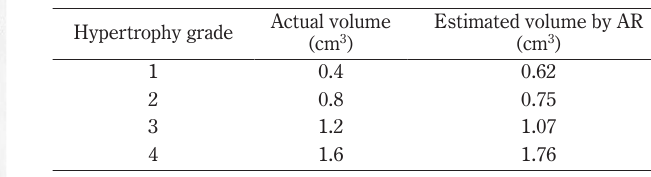
Table 1 Estimated and actual adenoid volumes by grade of hypertrophy